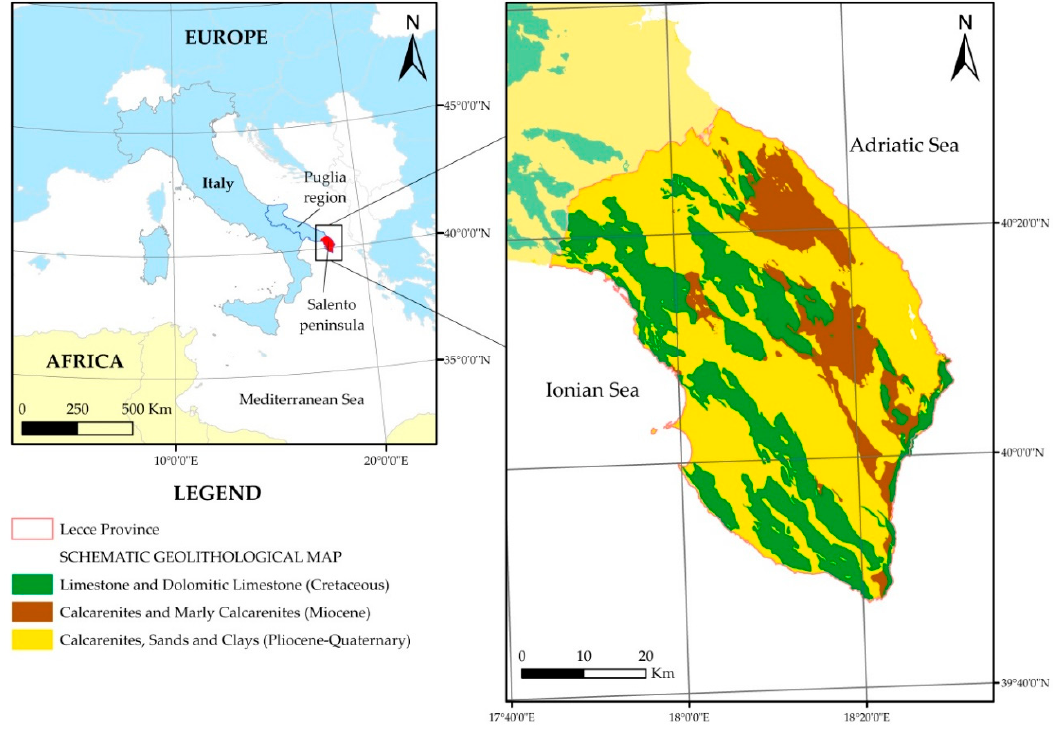
Figure 1. Location of Salento Peninsula and schematic geological map.